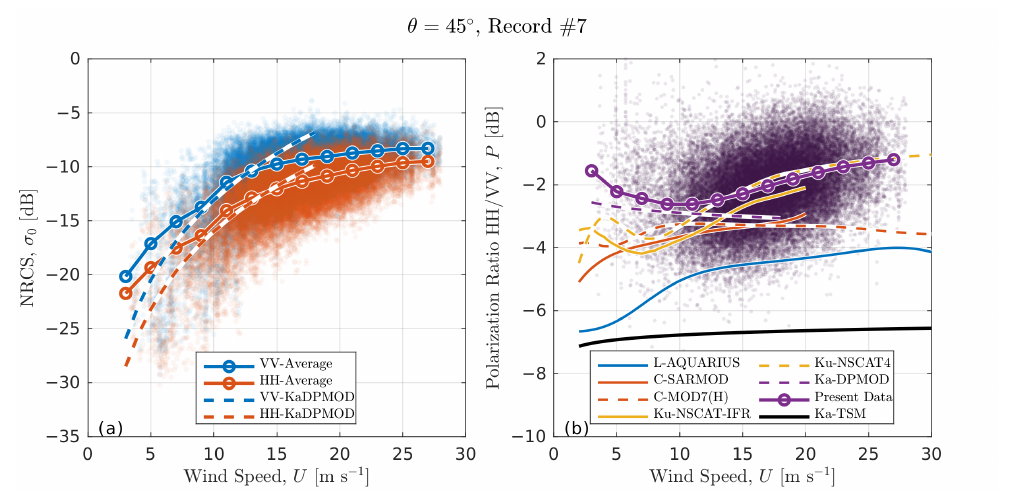
Figure 6. Measured ( a ) NRCS, σ 0 , and ( b ) polarization ratio, P = σ hh Each point in data clouds corresponds to 0.2-s average. Open circles are 2 m s − 1 wind speed bin averages. No-mark solid and dashed lines show model